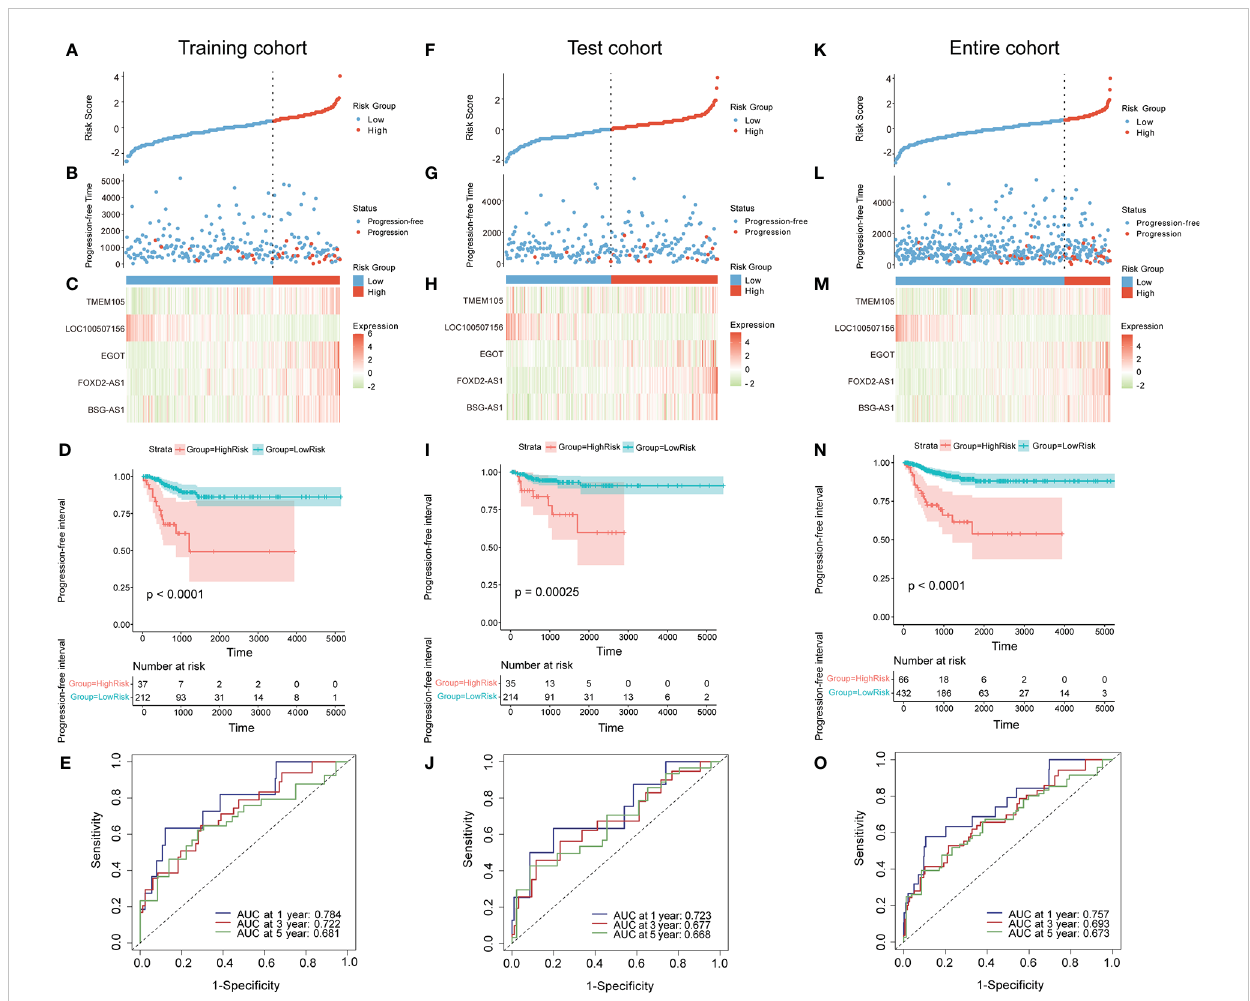
FIGURE 2 Construction and validation of a CCR-lncRNA-based prognostic signature. (A, F, K) PTC patients were sorted by risk score in the training, test, and entire cohort (B, G, L) PFI status of PTC patients in the training, test, and entire cohort. (C, H, M) Heatmap of the expression of fi ve CCR-lncRNAs in the training, test, and entire cohort. (D, I, N) Kaplan – Meier curve analysis of the high- and low-risk groups in the training, test, and entire cohort. (E, J, O) Time-dependent ROC curves for 1-, 3-, and 5-year PFI predictions for the signature in the training, test, and entire cohort. CCR-lncRNAs, cell cycle – related long non-coding RNAs; PTC, papillary thyroid carcinoma; PFI, progression-free